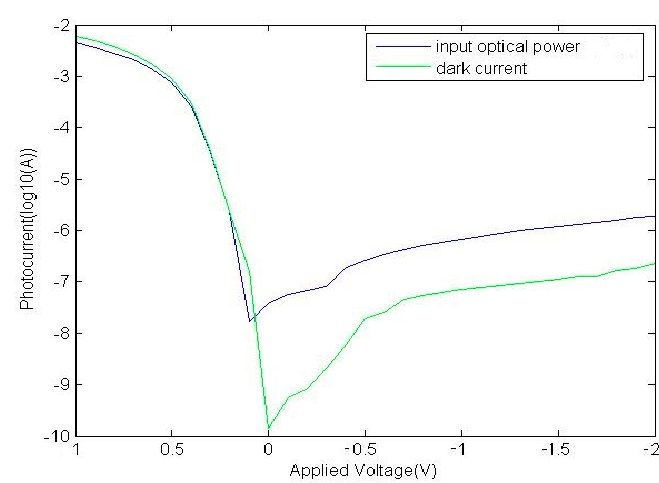
Figure 9. Measured current–voltage characteristics of the Ge photodiode under 1550-nm optical power (100 µW) and dark condition.